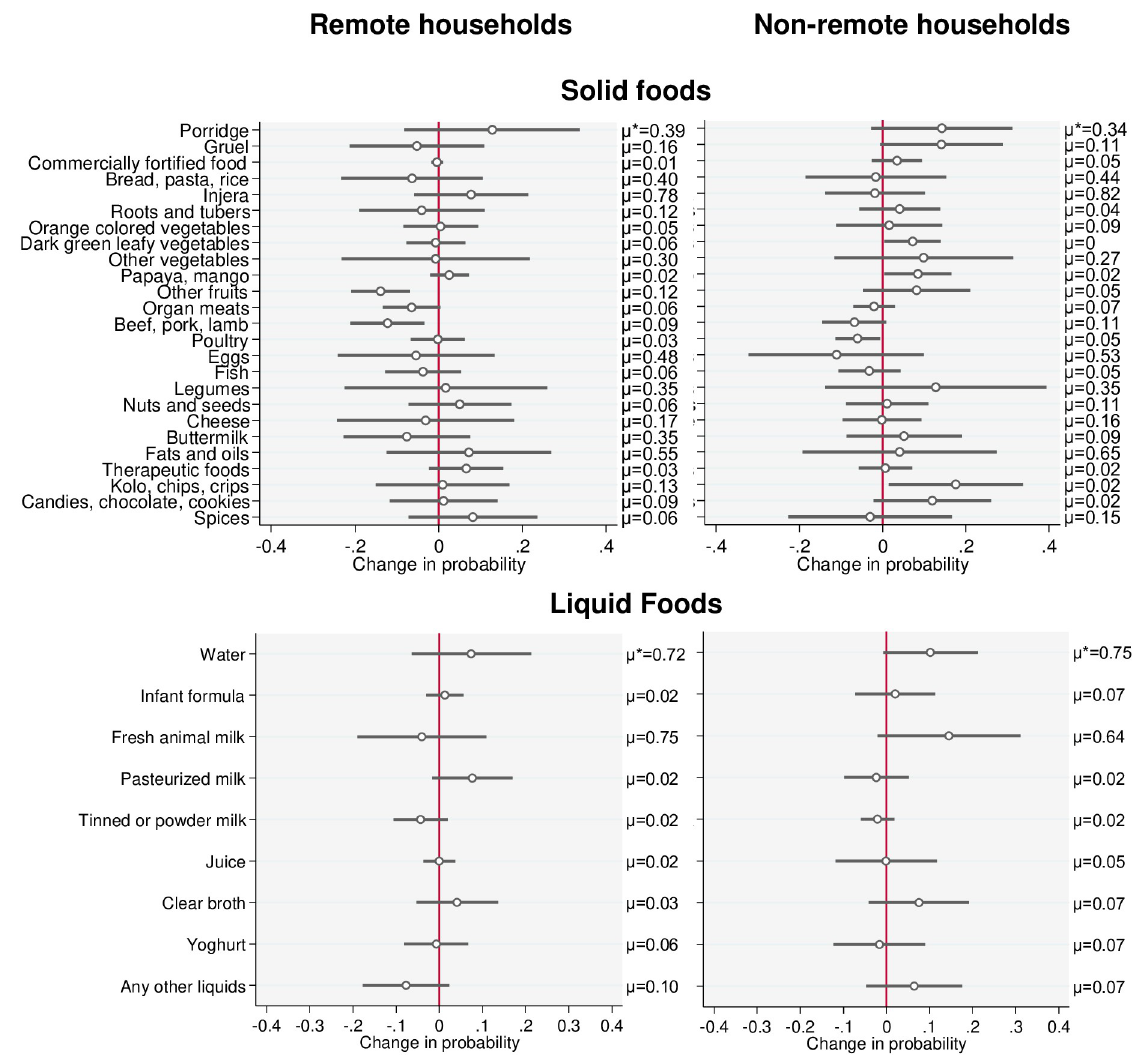
Fig 4. Impact of a fasting day on likelihood of daily consumption of different food groups for children in remote and non-remote households.